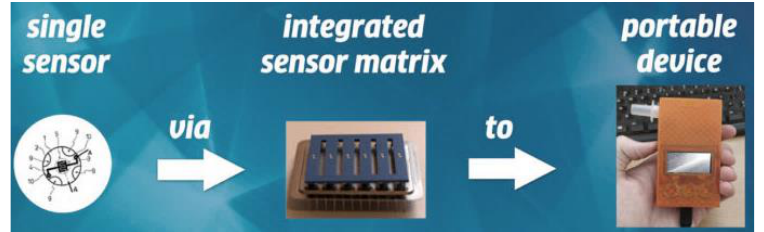
Molecules 2023 , 28 , x FOR PEER REVIEW Figure 10. “Diabetomat” developed by Dr. Artur Rydosz ( adapted from [108]). Figure 10. “Diabetomat” developed by Dr. Artur Rydosz (adapted from [108]). Figure 10. “Diabetomat” developed by Dr. Artur Rydosz ( adapted from [108]).